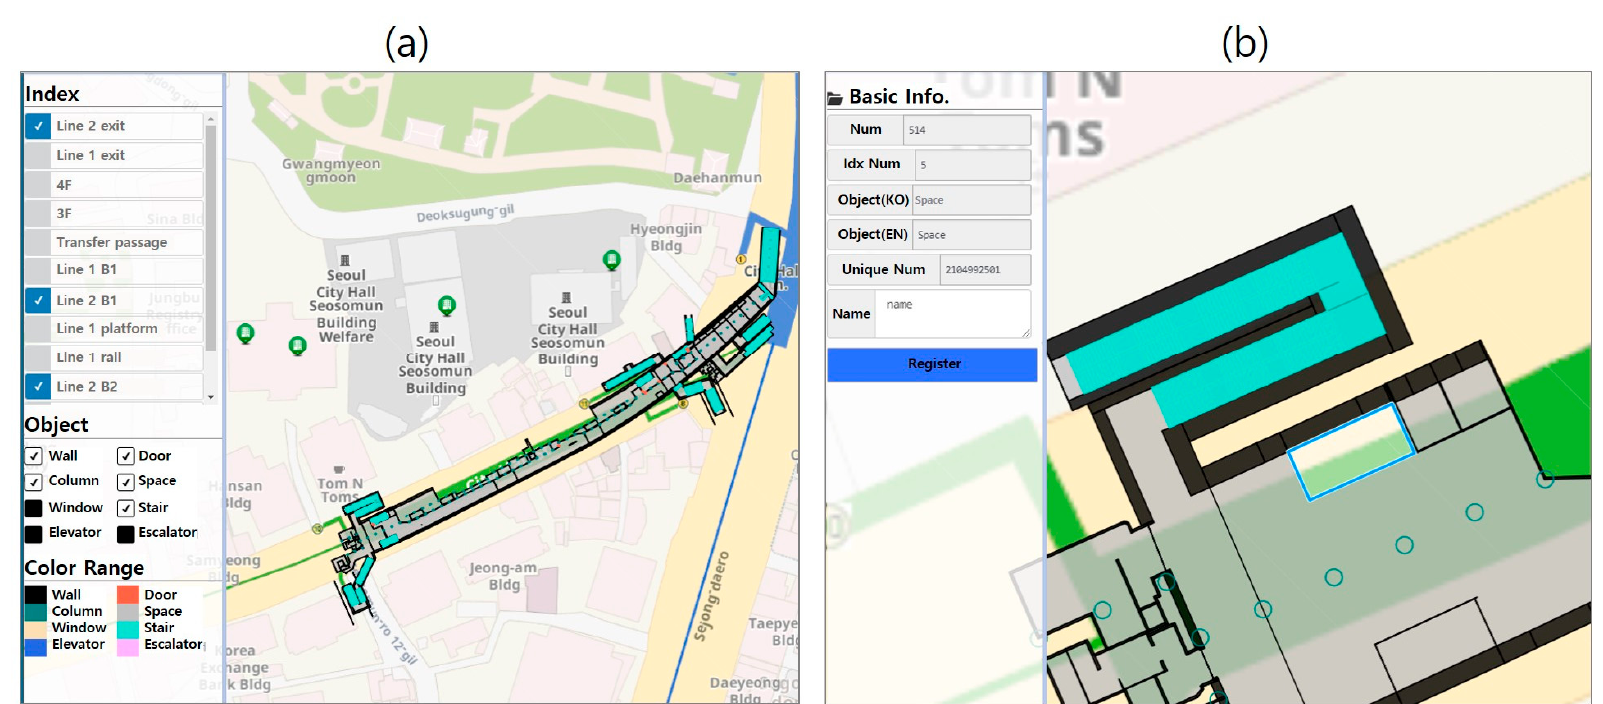
Figure 3. Implemented cases: ( a ) 2D data visualization, and ( b ) attribute information.